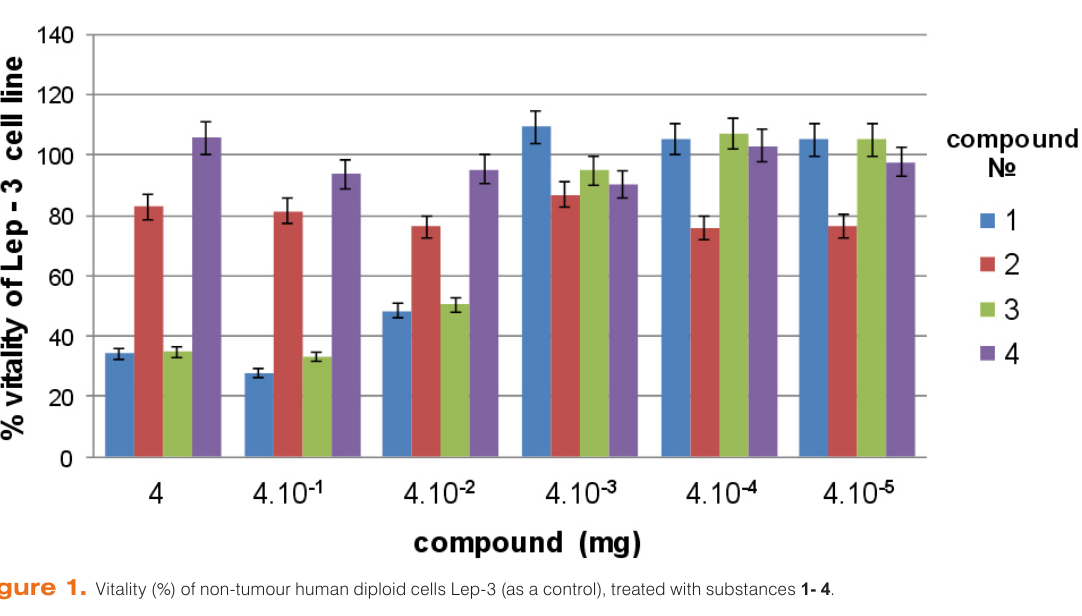
Figure 1. Vitality (%) of non-tumour human diploid cells Lep-3 (as a control), treated with substances 1- 4 .